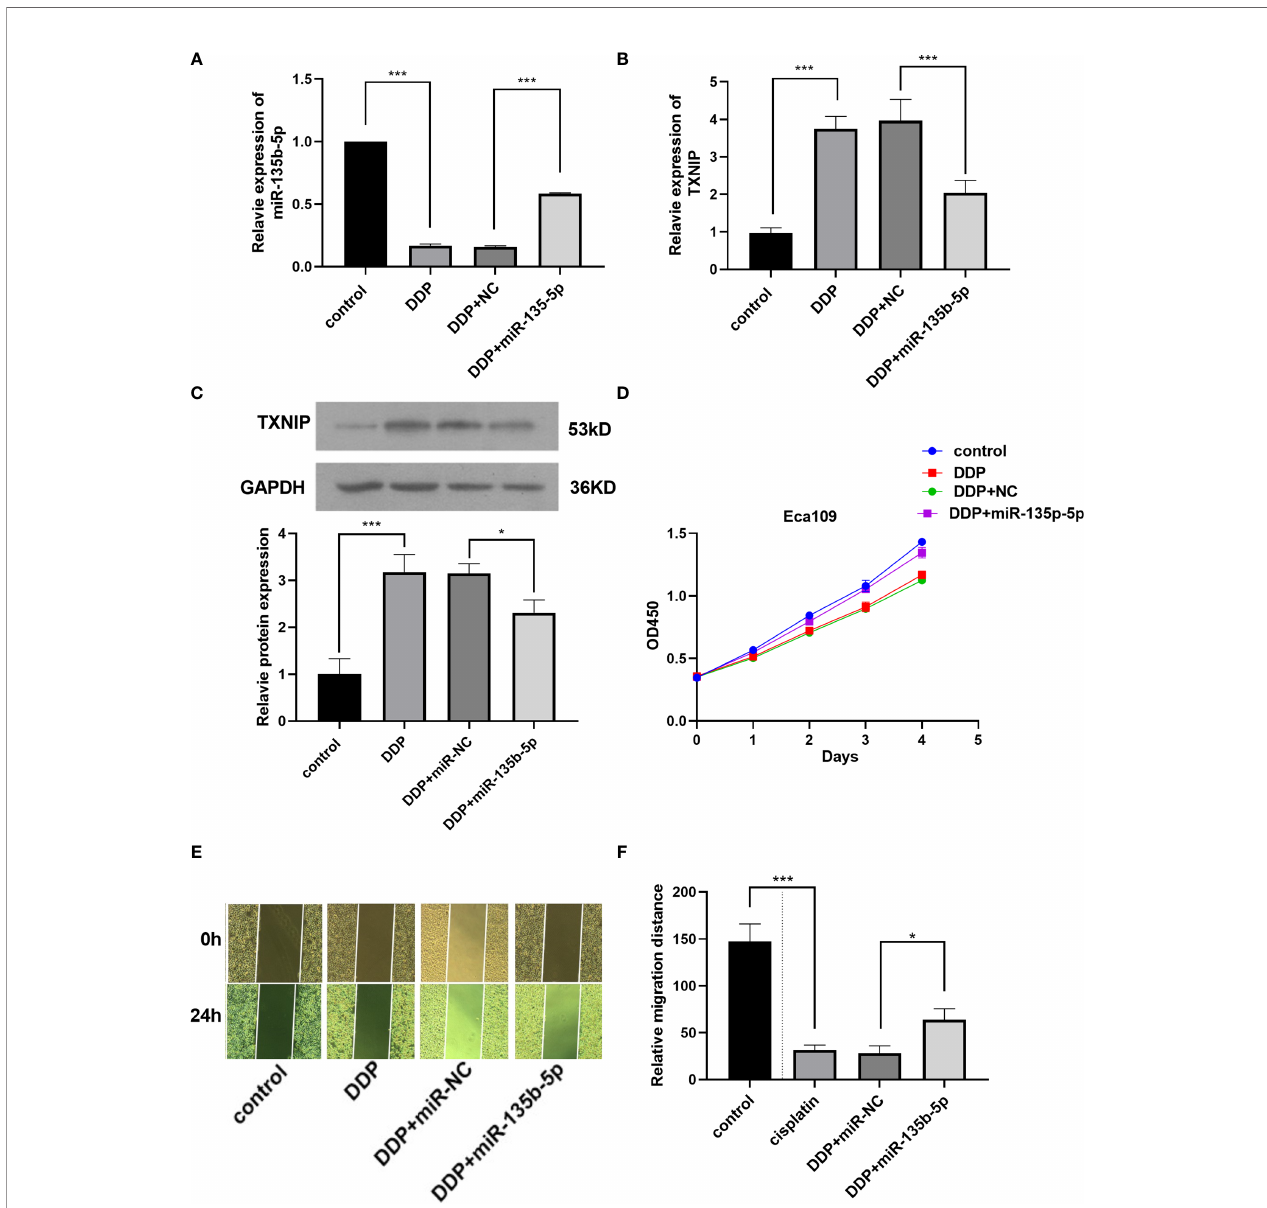
FIGURE 6 | MiR-135b-5p/TXNIP axis contribute to the anti-tumor effect of cisplatin (DDP) for EC. (A) MiR-135b-5p expression level. (B) TXNIP mRNA expression level. (C) TXNIP protein expression level. (D) The miR-135b-5p mimics attenuated the inhibitory effect of DDP on the viability of Eca109 cells. (E, F) The miR-135b- 5p mimics weakened the inhibitory effect of DDP on the migration ability of Eca109 cells. (*p < 0.05, ***P <